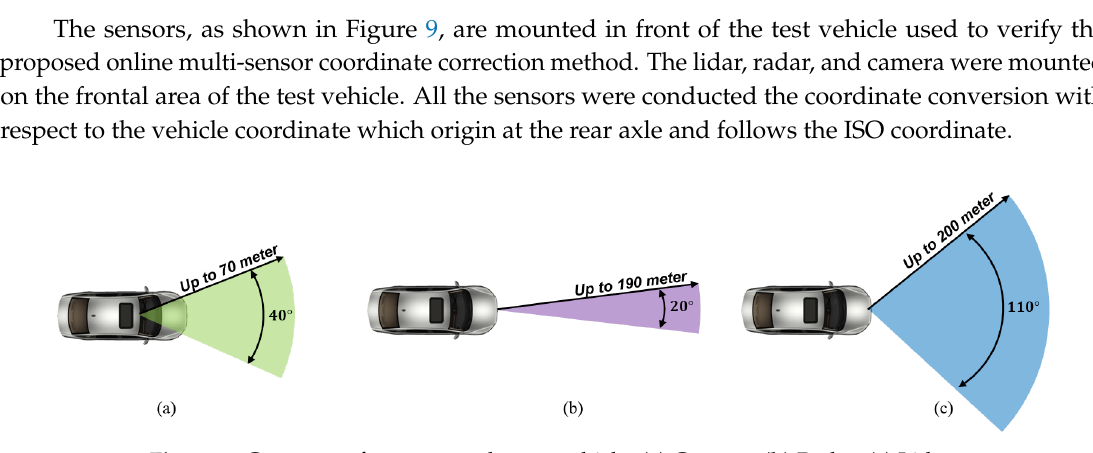
Figure 9. Coverage of sensors on the test vehicle: ( a ) Camera. ( b ) Radar. ( c )